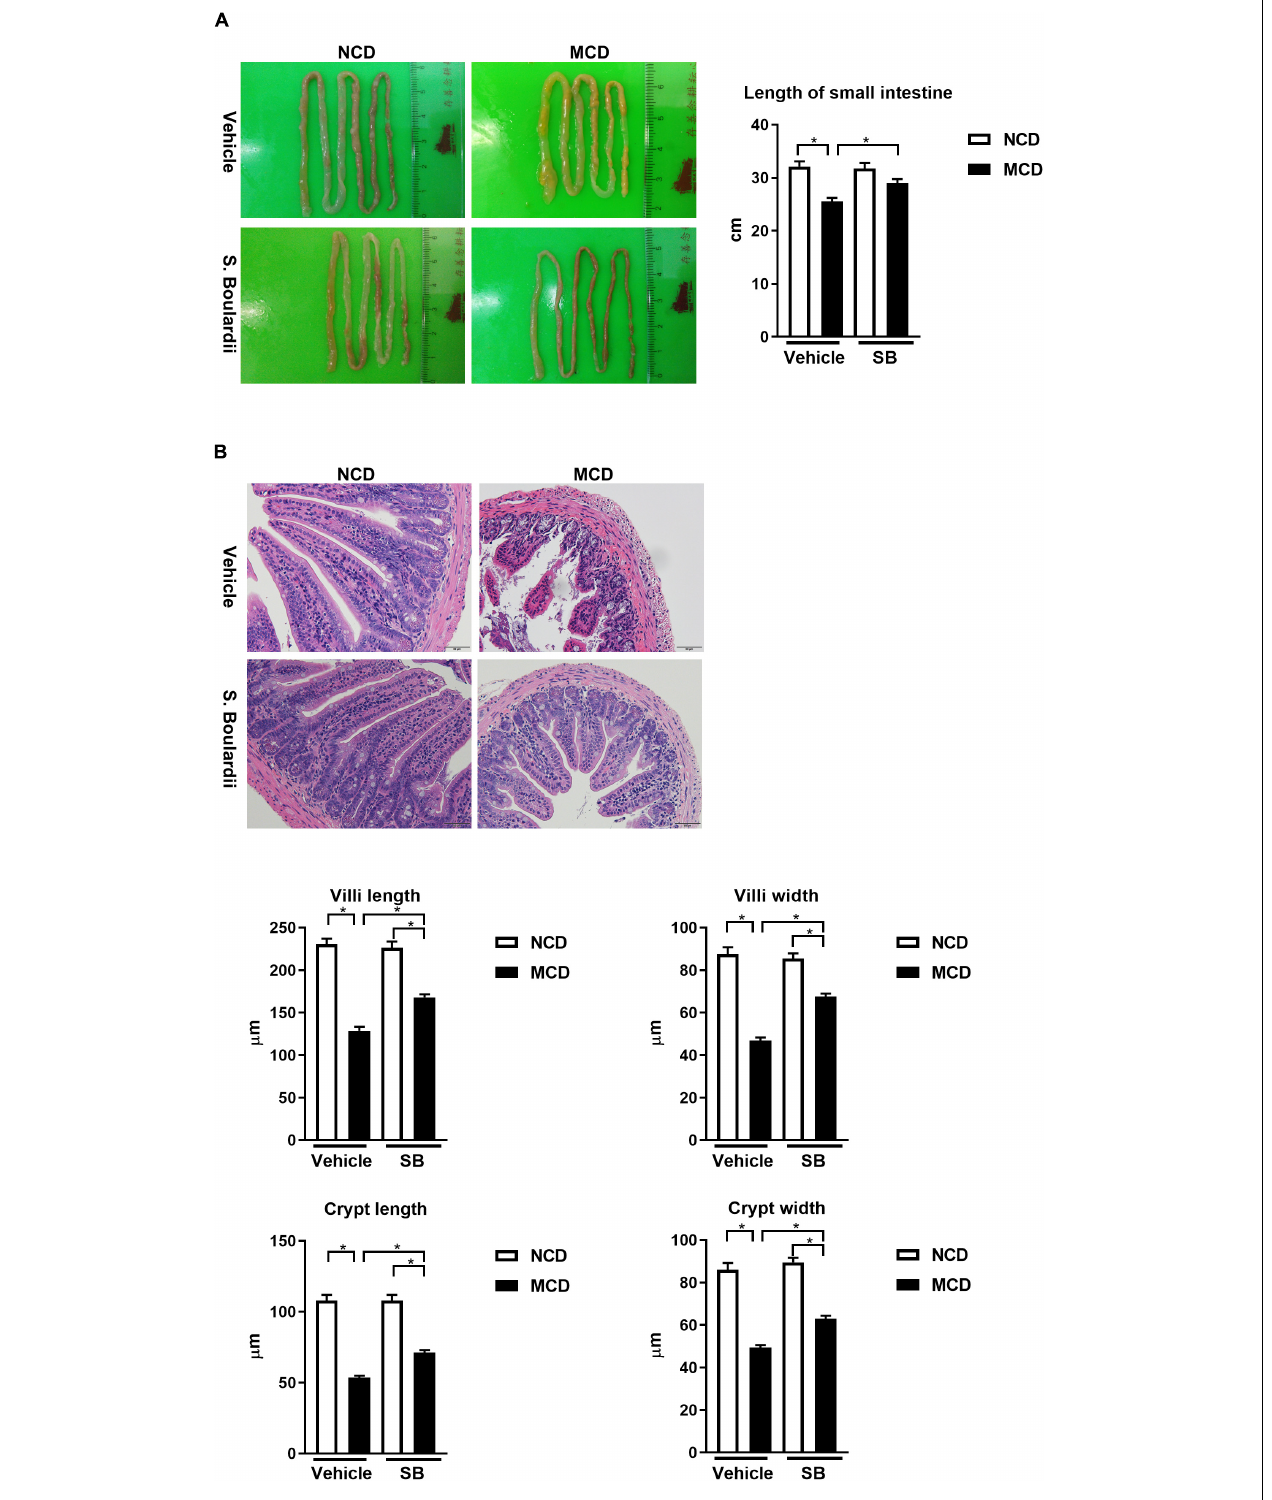
FIGURE 4 | The MCD diet led to the shortening of the small intestine and intestinal villi, which were improved by the SB supplement. (A) Representative images of the small intestine of mice on the control diet ( n = 10) or the MCD diet ( n = 18), and also given vehicle or SB . The length of the small intestine improved after the SB supplement. (B) Representative sections of the distal small intestine after H & E staining. Both the intestine length of villi and the width of crypt improved after the SB supplement. Scale bars: 50 µ m. * p < 0.05.